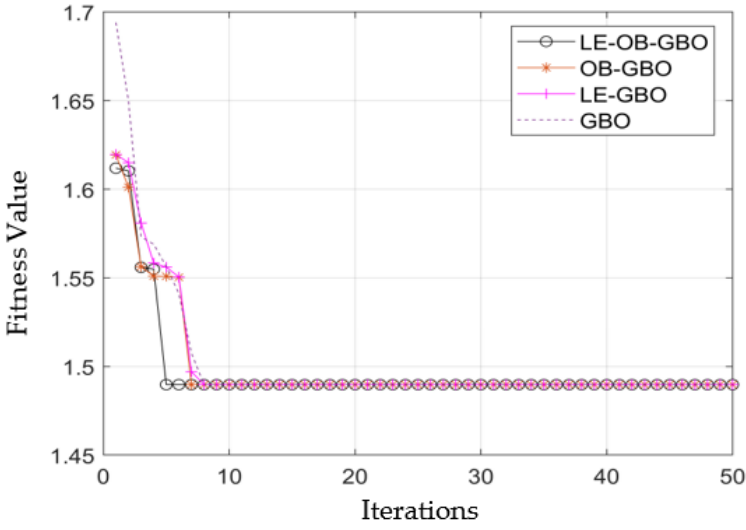
Figure 7. Convergence curve for the charging station placement problem—case 3. Table 5. Optimal placement of the charging station—case 1.